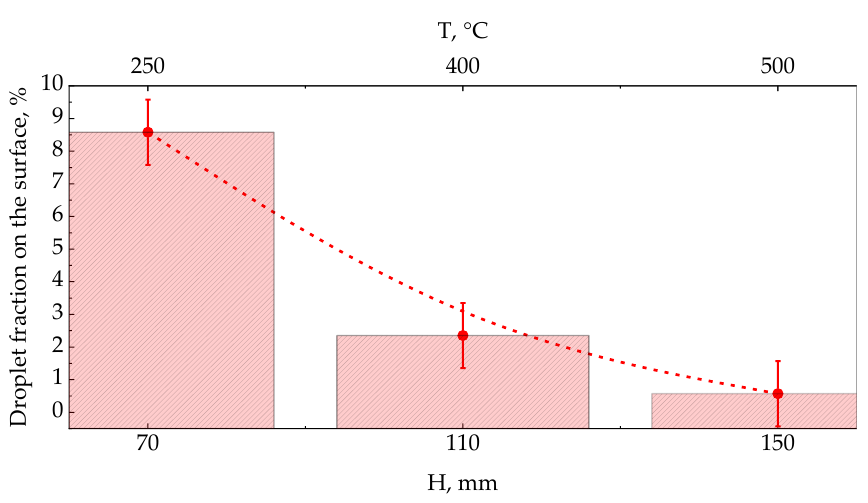
Figure 5. Graph of the ratio of the number of drops per unit area of temperature, T, and the distance between the substrate and the target, N, at a fixed pressure value in the chamber, P = 1 torr.